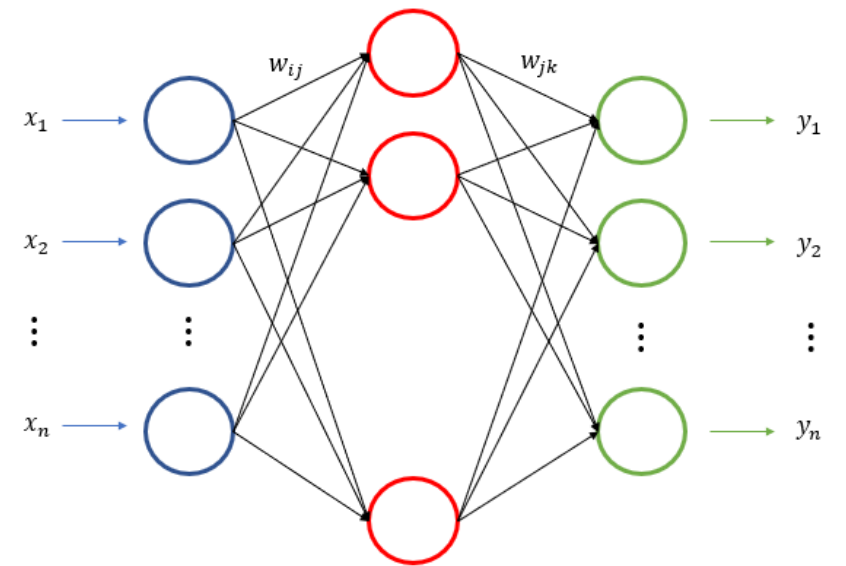
Figure 5. Multi-Layer Perceptron according to the Universal Approximation Theorem.